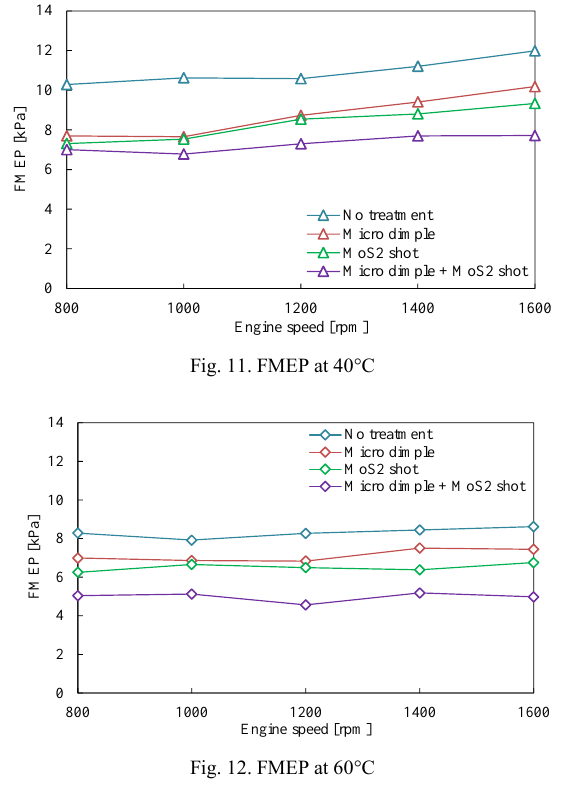
Fig. 12. FMEP at 60°C